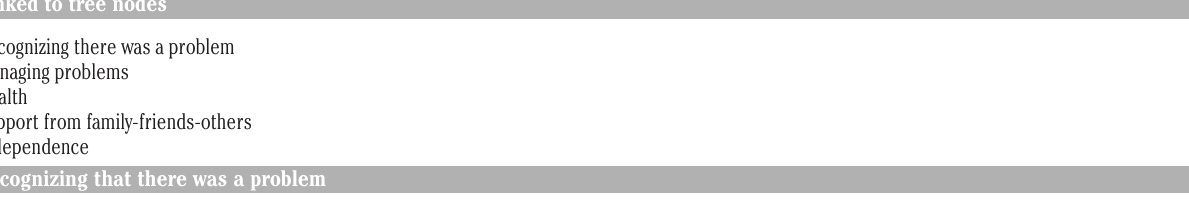
Table 1. Managing-struggling (memo).